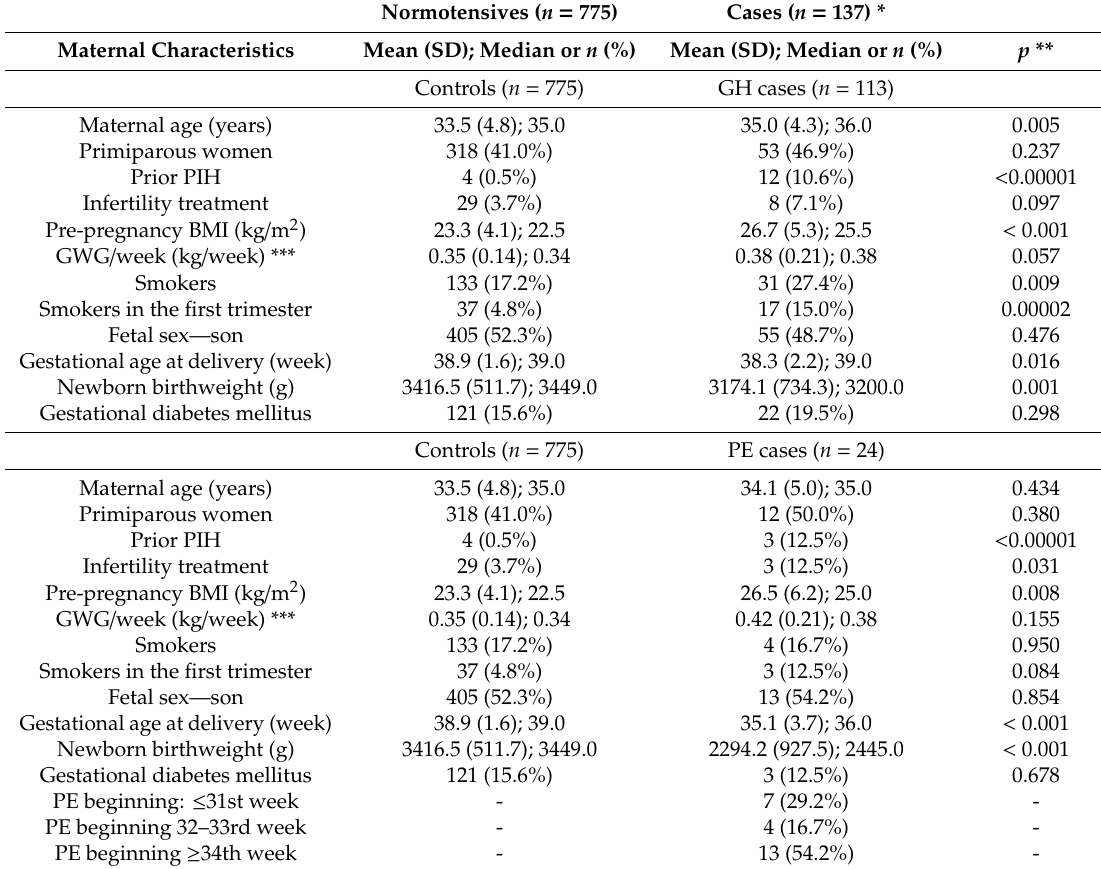
Table 1. Maternal characteristics in the control and study